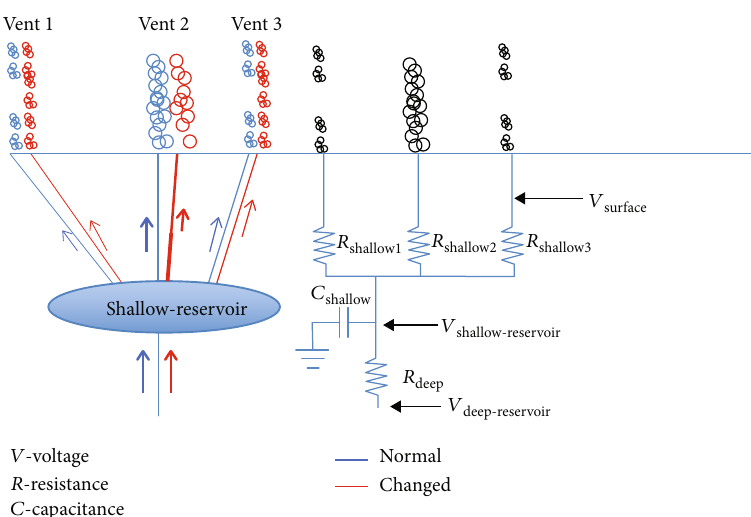
Figure 4: Seep electrical model schematic illustrating e ff ect of blockage in one of multiple migration pathways from a shallow reservoir, which is fed from a deeper source. Arrow thickness indicates the fl ow rate.